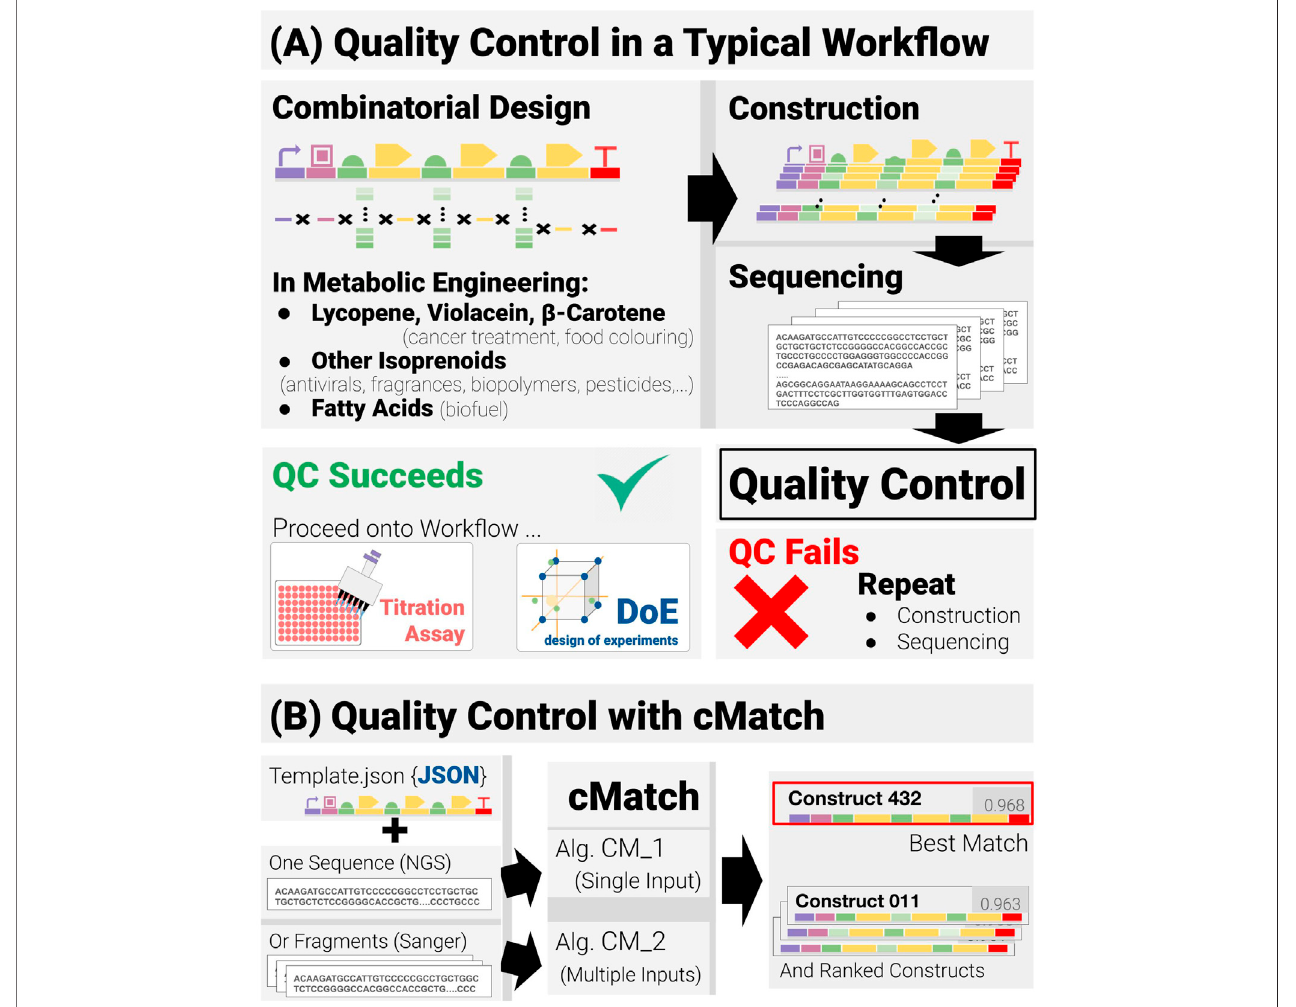
FIGURE1| Qualitycontrolincombinatorialpathwayengineeringwork fl ows (A) Qualitycontrolliesatthejunctionbetweentheconstructionandassayphasesofthe work fl owand actsasabinarycheckonwhether thework fl owmayproceedorifconstructionand veri fi cation mustberepeated. (B) Thequality-controlsoftware cMatch uses two types of inputs: a JSON template encoding the positional and combinatorics constraints for a given search space, and sequence data. Sequence data can either be single-input, long-read data (as with next-gen sequencing) or multiple-input, short read data (typical of Sanger sequencing). Two algorithms, CM_1 and CM_2 have been implemented — each tailored for atype of input (CM_1 for single input, CM_2 for multiple input). cMatch returns a best match, as well as aranking of all the construct in the search space (or an error log).